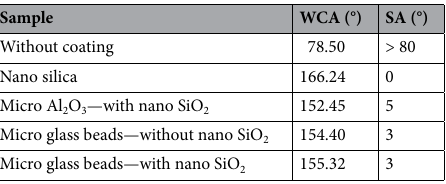
Table 3. Water contact angle (WCA) and sliding angle (SA) of bare sample and sample with superhydrophobic coatings.